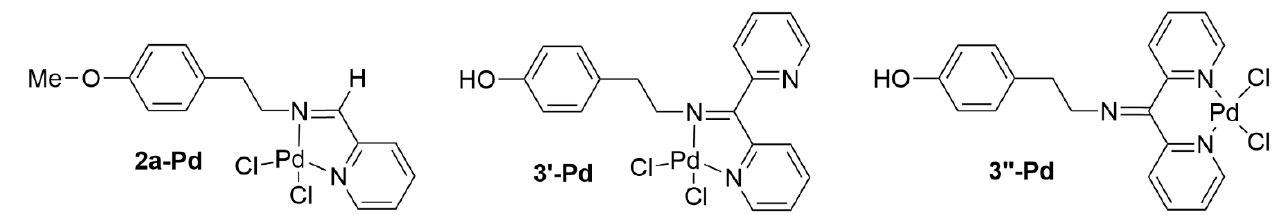
Figure 10. Complexation of compound 2a , and the two possible forms of the Pd complex of 3 .